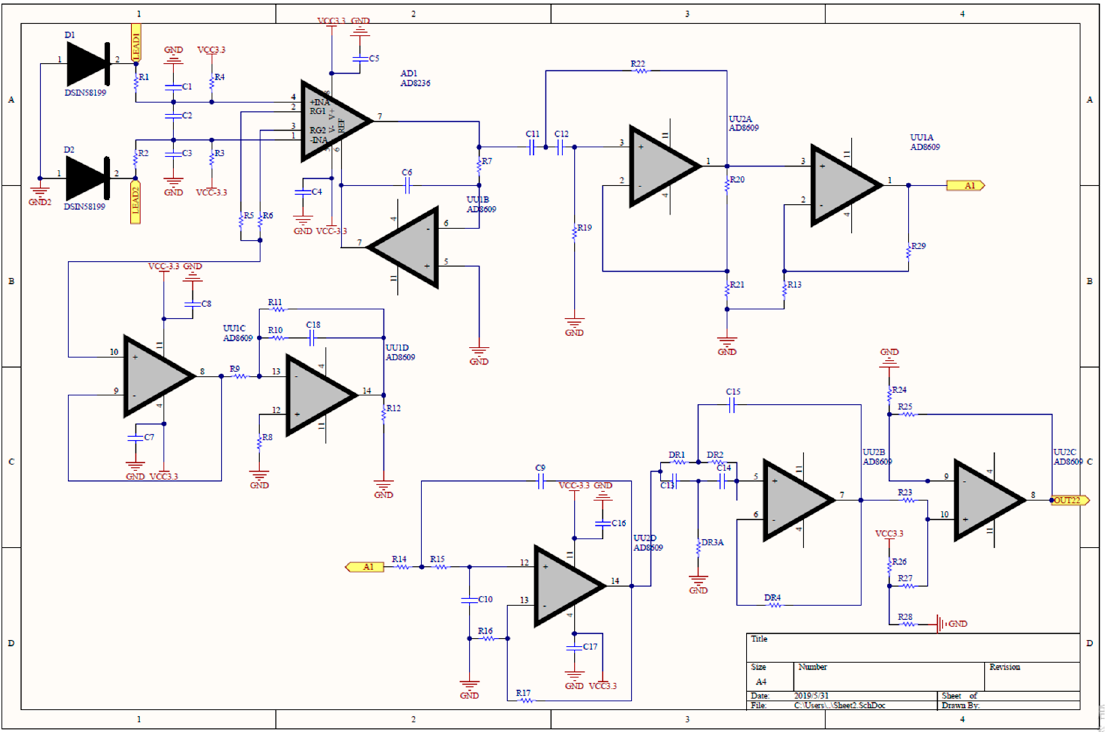
Figure 3. Analog circuit of the EMG patch.